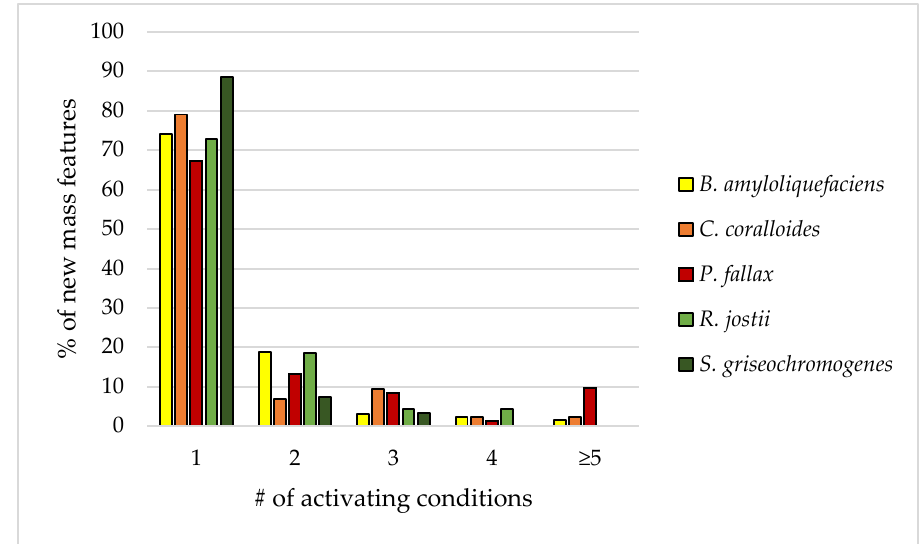
Figure 7. Percentage of new mass features that are activated by a certain number of culture conditions.